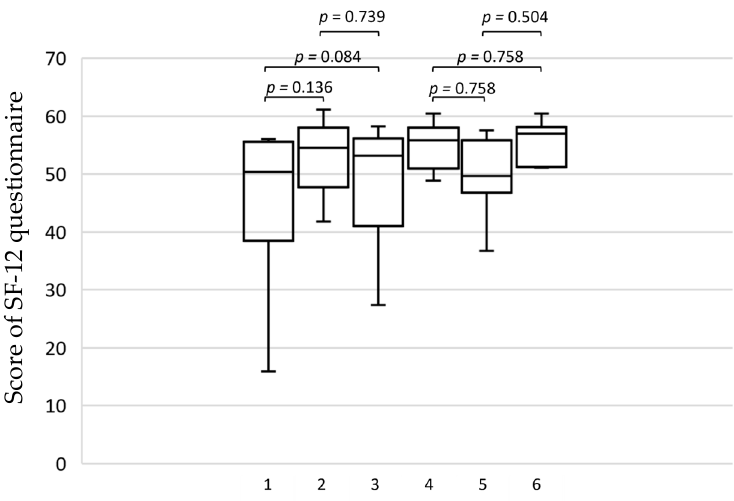
Figure 3. Median and range of the physical and mental health between compression class I and class II assessed with SF-12 questionnaire. 1: physical score at baseline, 2: physical score after wearing compression stocking of class I for four weeks, 3: physical score after wearing compression stocking of class II for four weeks, 4: mental score at baseline, 5: mental score after wearing compression stocking of class I for four weeks, 6: mental score after wearing compression stocking of class II for four weeks.